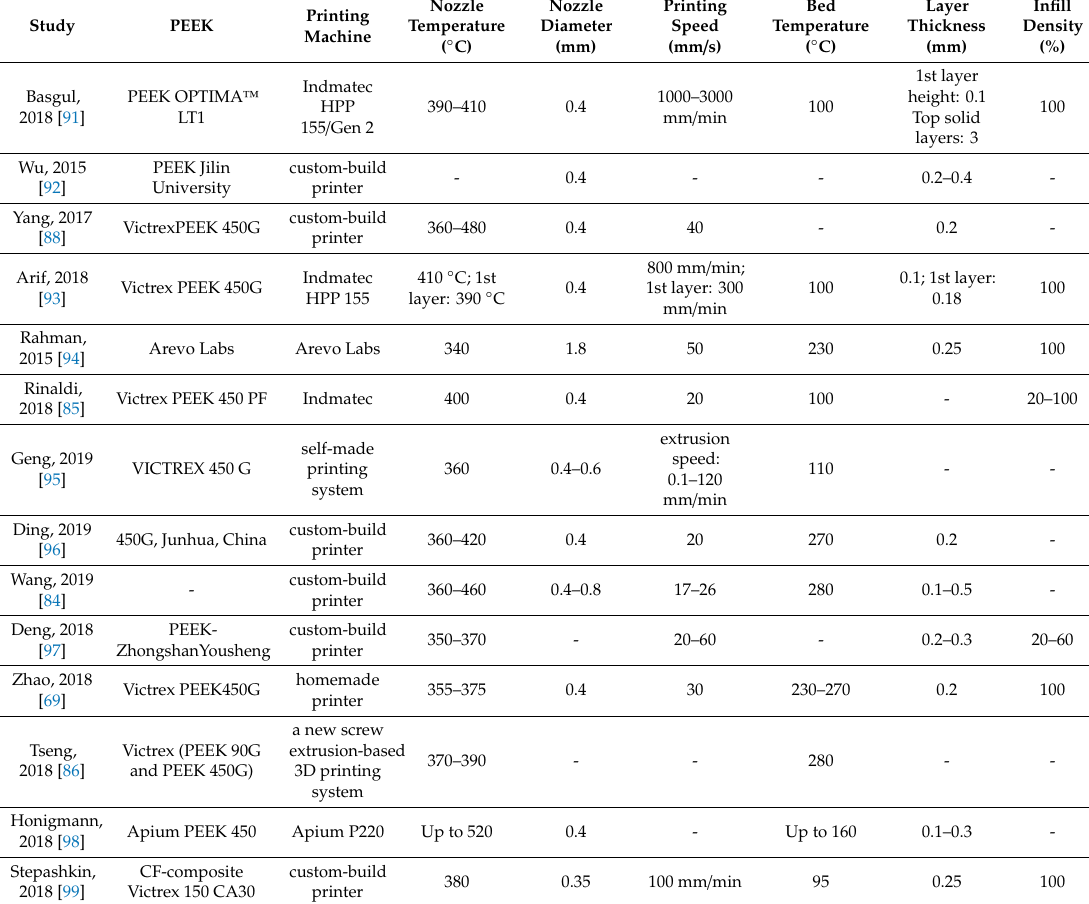
Table 2. 3D printing parameters of PEEK via fused filament fabrication